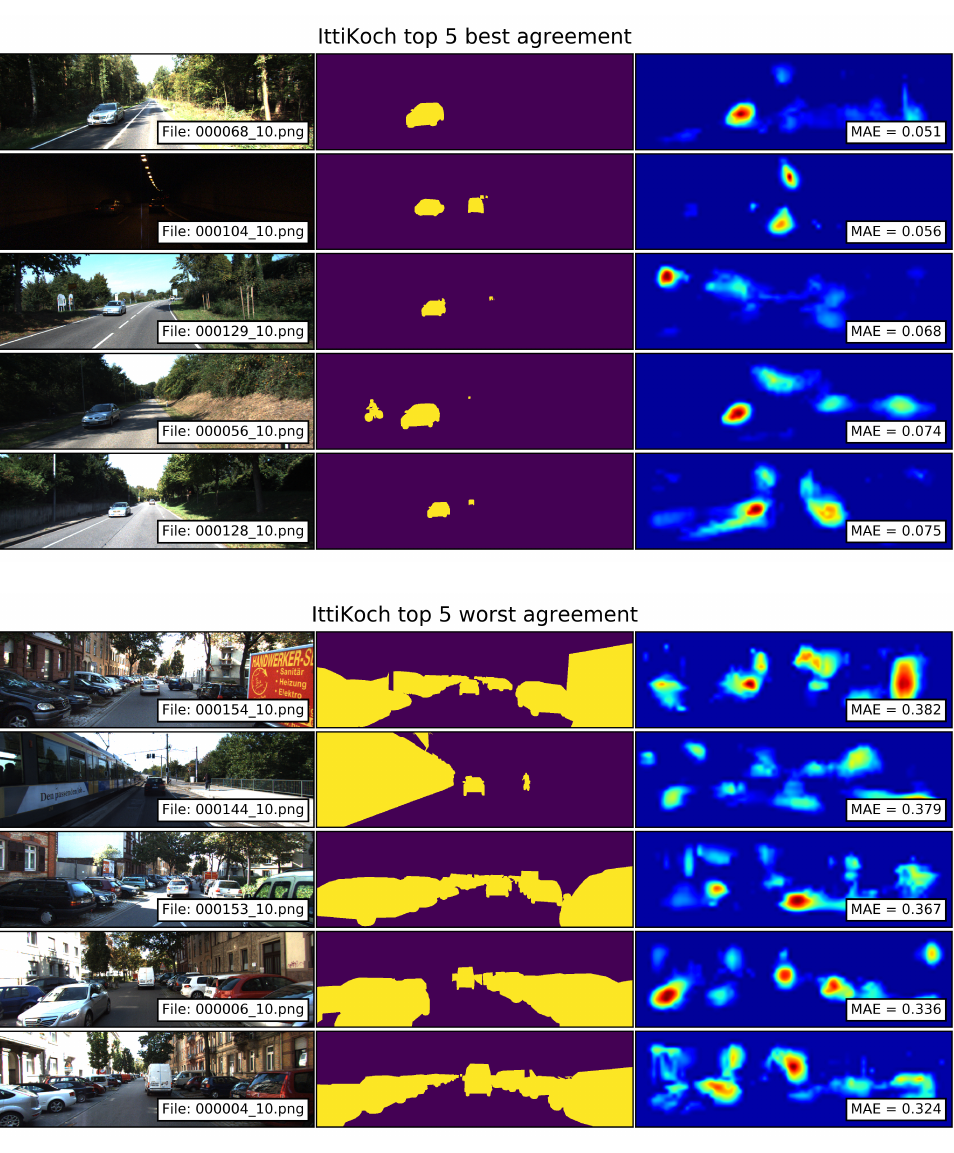
Figure 10. Top 5 best and worst agreements between the segments of traffic participants and the saliency maps computed with the IttiKoch model. Smaller MAE values correspond to a better